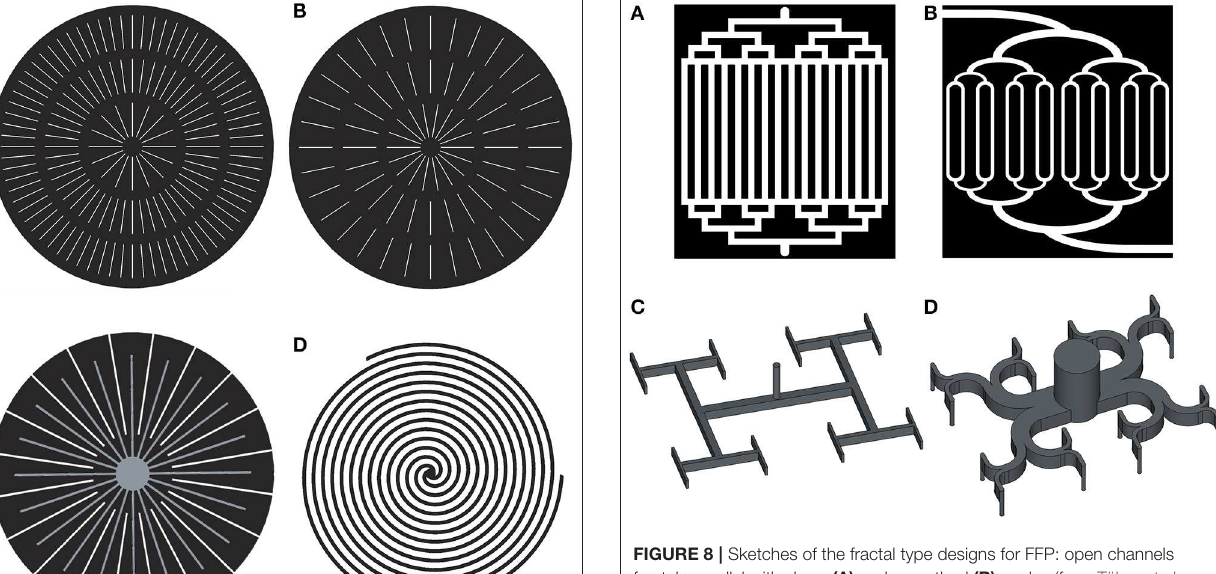
FIGURE 8 | Sketches of the fractal type designs for FFP: open channels fractal + parallel with sharp (A) and smoothed (B) angles (from Tüber et al., 2004 ), and closed channels fractal tree with sharp (C) and smoothed (D) branching angles, from Luo and Tondeur